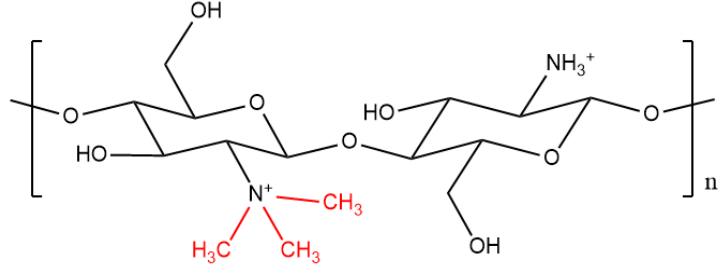
Figure 3. Structure of N , N , N -trimethyl chitosan (methyl groups are shown in red).